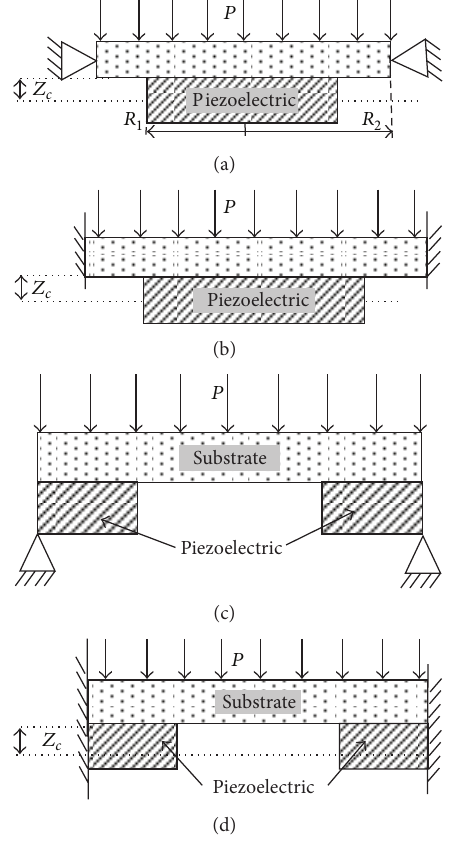
Figure 1: Piezoelectric energy harvester